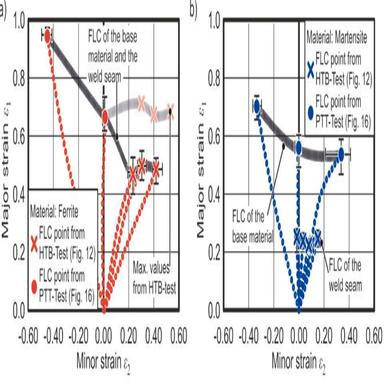
Combined FLC for a) ferritic- and b) martensitic stainless steel tube material.